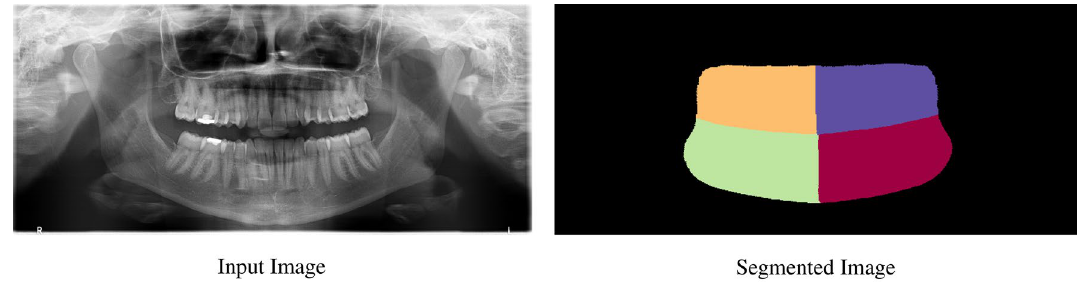
Figure 4. Output of the quadrant segmentation